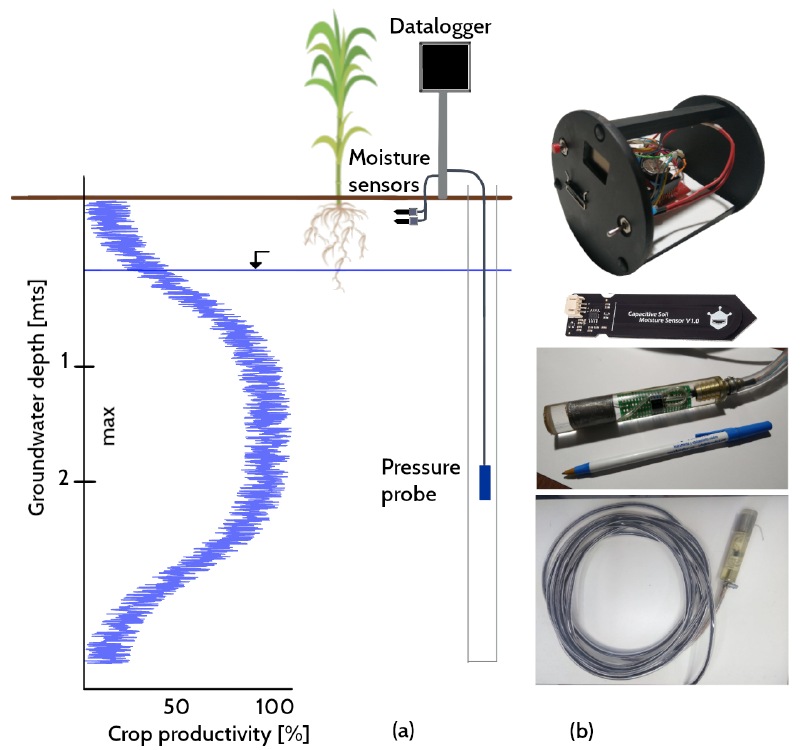
Figure 1. ( a ) Schematic of crop yields, which may be optimal within certain water table elevation ranges (the fitted curve has a wide scatter band and varies for corn, soybeans and wheat, accord- ing to Nosetto et al. [7]); ( b ) datalogger housing, sensor SKU: SEN0193 and pressure probe with Honeywell